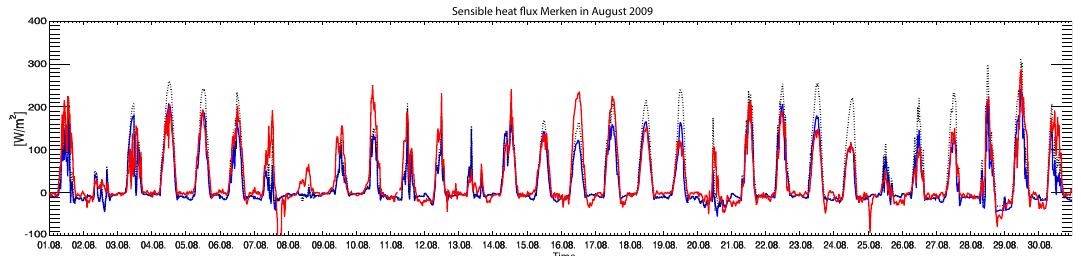
Figure 8. Surface sensible heat flux in August 2009. The black dotted curve shows the CLM forecast without assimilation (control run) and the blue curve shows the analysis. Measurements are plotted in red.